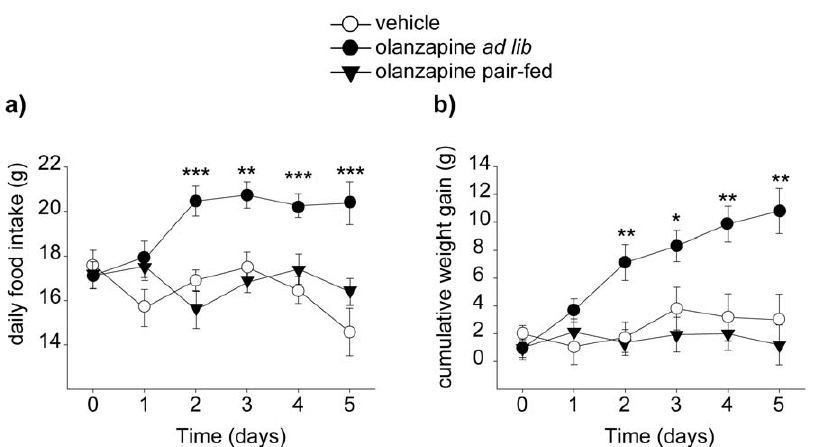
Figure 3. Food intake and body weight following subchronic administration of olanzapine. a) Daily average food intake in groups of rats (n=8) exposed to olanzapine or vehicle by gavage (b.i.d) for 5 consecutive days. Rats were fasted over night and sacrificed in the morning on day 6. b) Cumulative weight gain in groups of rats (n=8) treated with vehicle or olanzapine for 5 consecutive days. Total relative weight gain (mean 6 SEM), relative to treatment day 0 was as follows: control 3.0 6 1.8 g, olanzapine ad libitum 10.8 6 1.6 g, olanzapine pair-fed 1.2 6 1.4 g. * P # 0.05 vs. vehicle.